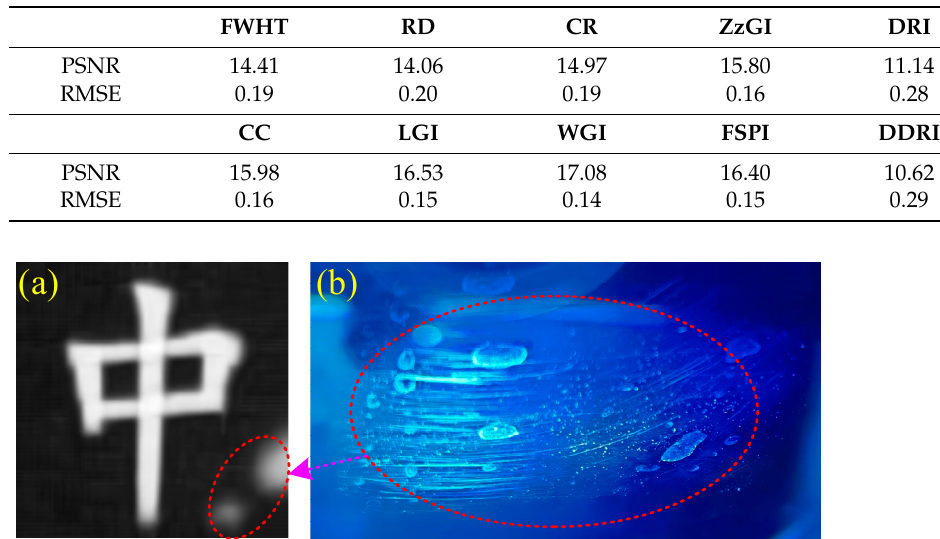
Figure 10. Experimental results of fourteen GI methods in the underwater environment (with WT, Table 6. PSNR and RMSE of images corresponding to the object “ 中 ” in Figure 9. without turbulence).